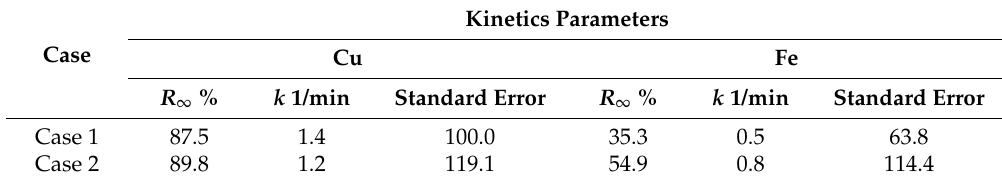
Table 9. Kinetics coefficients in optimized conditions for Case 1 and Case 2.